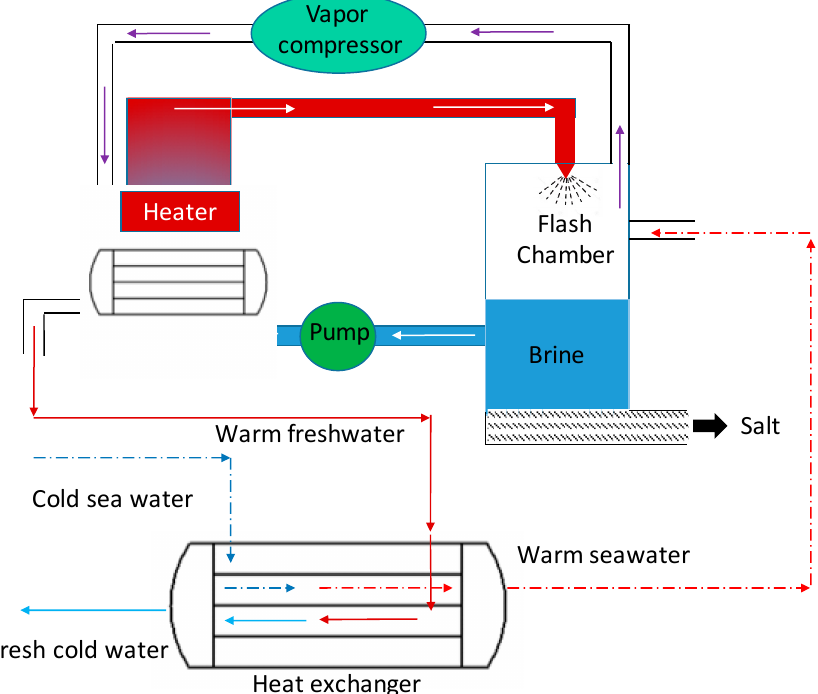
Figure 6. A thermal-based desalination strategy designed by EFD corporation .